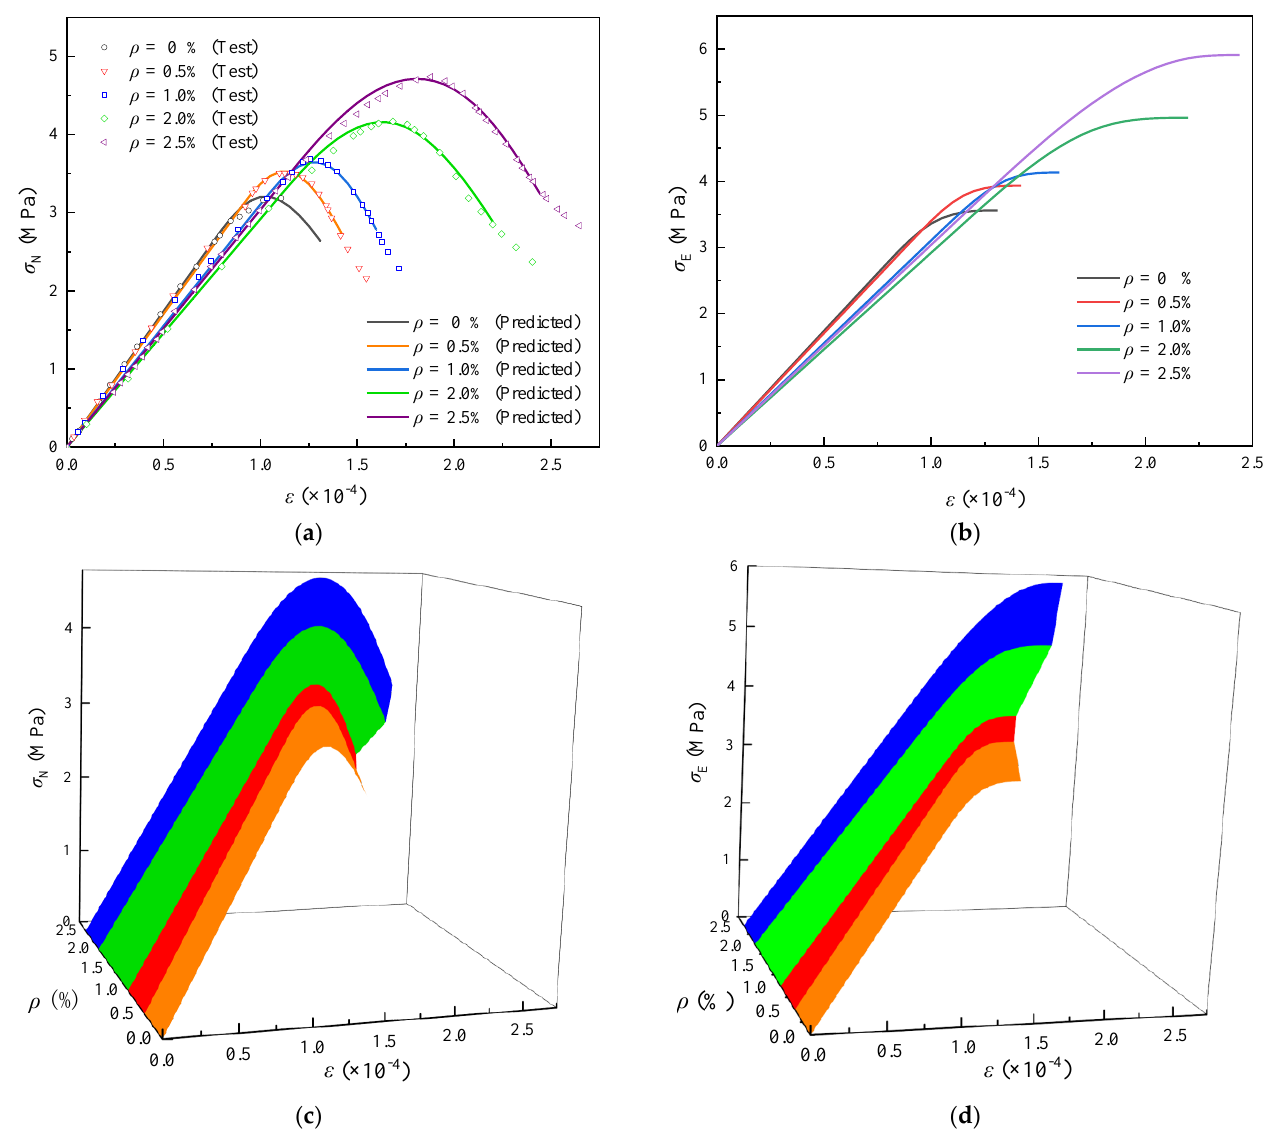
Figure 7. Stress – strain curves under uniaxial tension: ( a ) nominal stress – strain curve (Plan view); ( b ) effective stress – strain Figure 7. Stress–strain curves under uniaxial tension: ( a ) nominal stress–strain curve (Plan view); ( b ) effective stress–strain curve (Plan view); ( c ) envelope of the nominal stress – strain curve (3D view); ( d ) envelope of the effective stress – strain curve (Plan view); ( c ) envelope of the nominal stress–strain curve (3D view); ( d ) envelope of the effective stress–strain curve curve (3D view). (3D view). Table 3. Results for calculation parameter. Table 3. Results for calculation